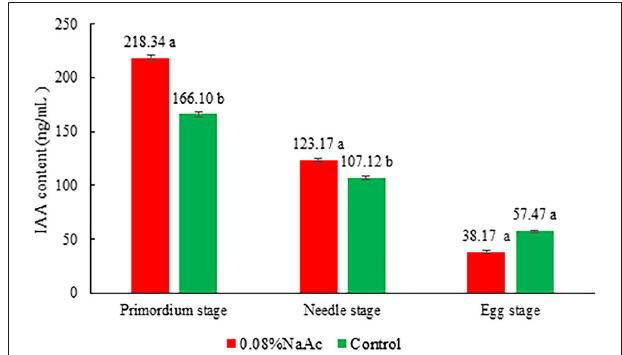
FIGURE 5 | Effects of 0.08% NaAc on the indole-3-acetic acid (IAA) content at different developmental stages. Different letters indicate significant differences by Tukey’s post-hoc test between the treatment and control groups at each stage, n = 3 at each